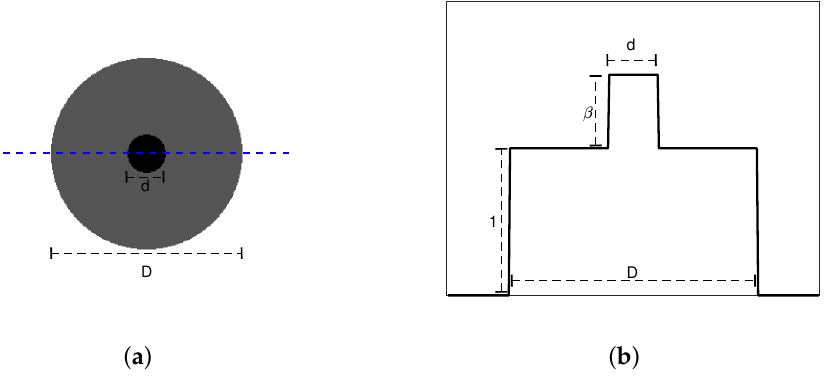
Figure 1. The exemplar object for which we will perform the calculation. ( a ) 2D view of the object. Dotted blue line represent a projection direction, passing by the central pixel. ( b ) Profile of the projection line represented in blue in the left